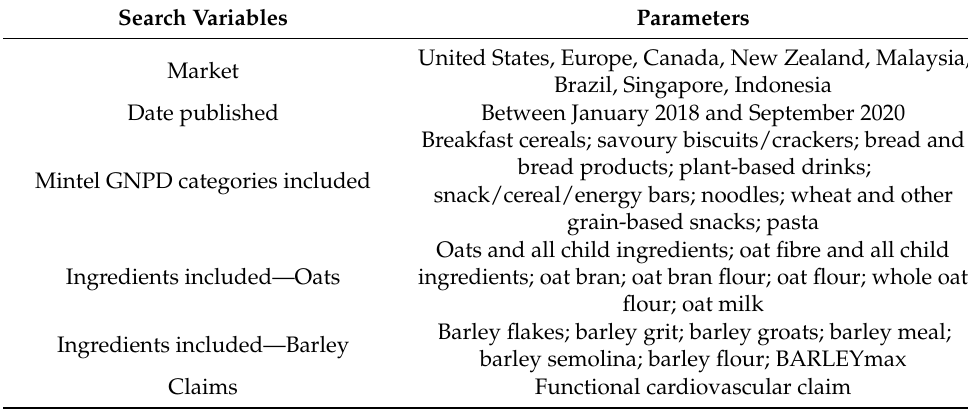
Table 1. Mintel GNPD search strategy.